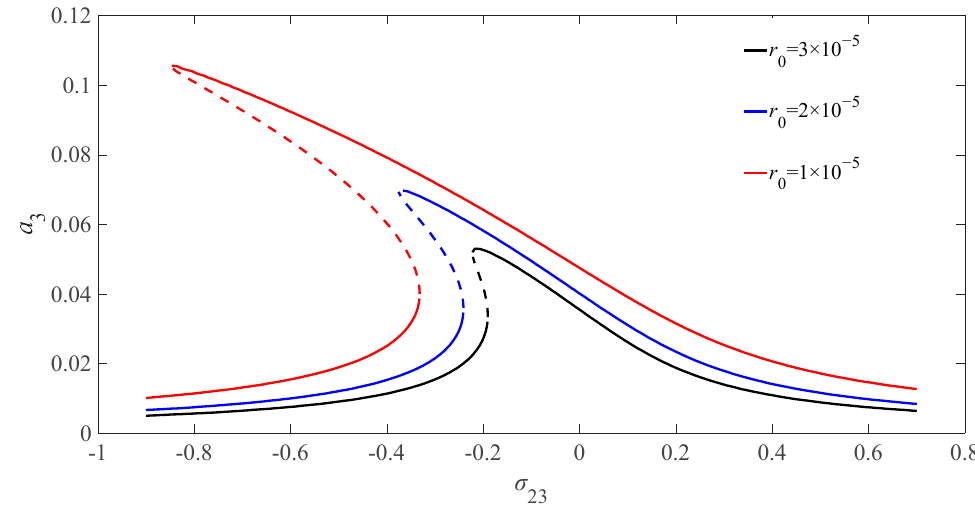
Figure 6. Diagram of resonant amplitude-frequency of nanobeam for different divided resistances.